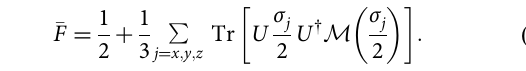
As indicated in Fig. 6, the fi delity of the X /2 gate